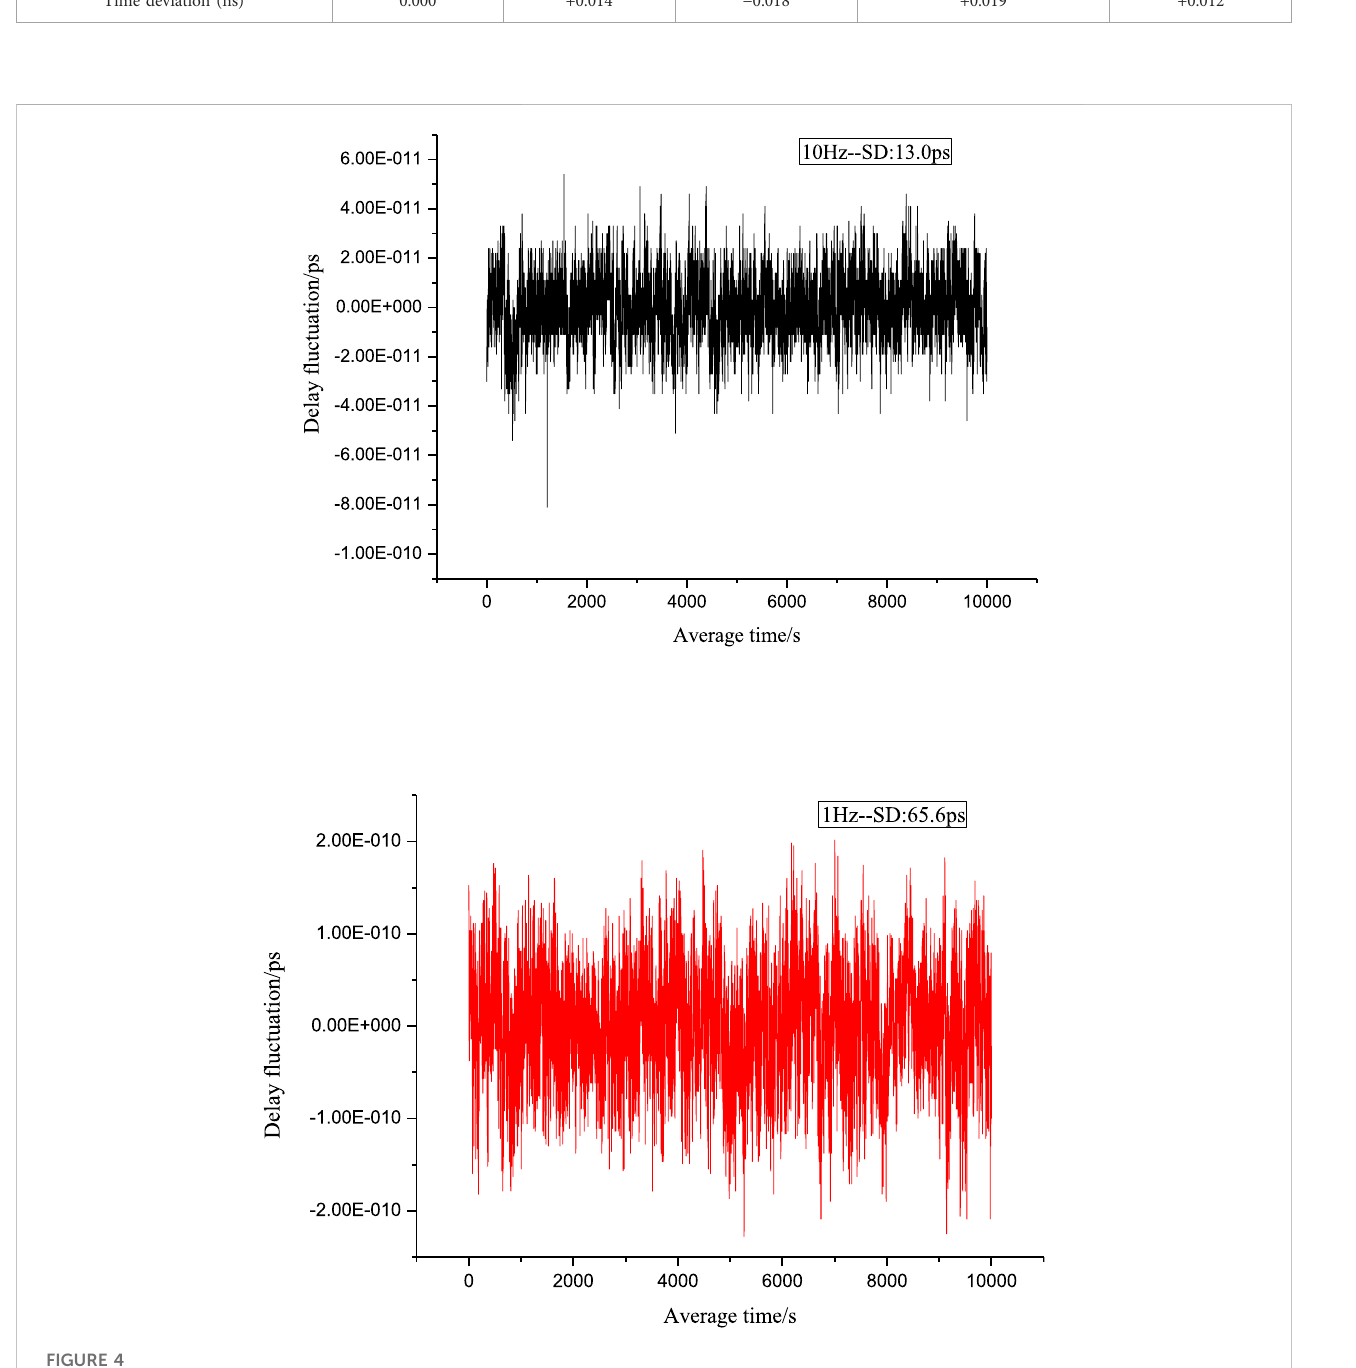
FIGURE 4 Delay fl uctuation before and after algorithm